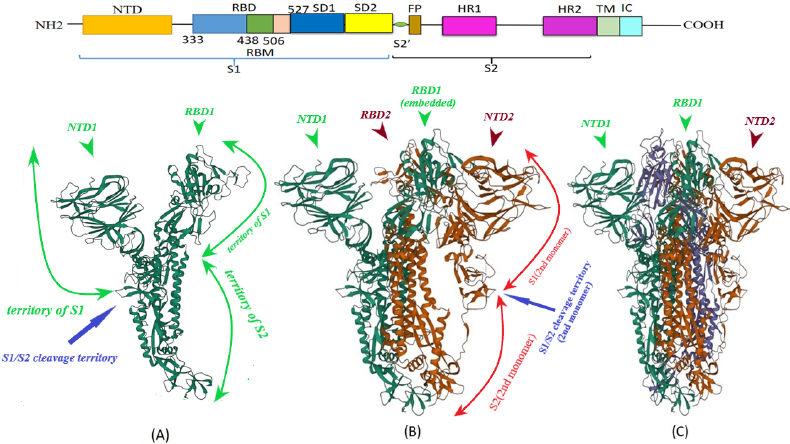
Figure 1. SARS-CoV-2 spike protein homotrimeric structure ( C ) (PDB ID: 7QUS [28]). Monomers (visualized as green, red and blue structures) are added one by one, from ( A ) to ( C ), to show how each monomer is folded and the dimeric as well as the trimeric structures are inter ‐ twisted. It makes boundary identification of S1/S2 interface in a three ‐ dimensional view difficult to show, yet has been depicted here by green curve arrows for simplification. The territory of S1/S2 cleavage site is also pointed (blue arrow). It is noticeable how in “closed, D” conformation (see the text, Section 3), RBD in the first monomer ( A ) is embedded in other S protein residues when the second ( B ) and third ( C ) monomers are added. This complex feature of S protein molecule leads RBDs to pack together as inaccessible domains in the “D” conformation (see the text below). NTD: N ‐ terminal domain; RBD: receptor binding domain. 3. Binding of ACE2 with RBD Increases the Chance of Further Complexification of ACE2 and SARS ‐ CoV ‐ 2 Binding of RBD with ACE2 is the first step of virus cell entry. Glycosylation of ACE2 and RBD residues may block this process [29]. However, RBDs in a trimeric S protein are not always accessible for this complexification and may be packed together [30]. Consti ‐ tutively, the RBD position within the S1 structure shifts dynamically through an intrinsic hinge ‐ like movement between “open or up (U)” and “closed or down (D)” states [23] (Fig ‐ ure 2). RBD in U status moves outward the apex of S1 domain to be ACE2 ‐ accessible while in D position it hides within the protein apex to be ACE2 ‐ inaccessible [31] (Figure 1 and Figure 2). As to the trimeric nature of S protein and considering U or D states of RBD, the apex of the trimeric S1 might harbor symmetric three open (UUU) or three closed (DDD) RBDs as well as intermediate asymmetric conformations of one open/two closed (UDD) or two open/one closed (UUD) ACE2 ‐ binding domains. The predominant RBD confor ‐ mation (UUU, DDD or other intermediates) differs in the variants of the SARS ‐ CoV ‐ 2 [32]. Recent studies attributed the escalated transmissibility and virulence of the new mutant variants to the abundancy and stability of RBD in the U state [32,33]. Moreover, according to cryo ‐ electron microscopy findings, docking of the single open RBD to ACE2 induces a rotation of the same domain which provokes its center of mass within the UDD complex to move approximately 5.5 Å away from the axis of the whole trimeric S protein molecule. This rotation is accompanied by moving of the three NTDs in the trimer of about 1.5–3.0 Å [34] which results in a reduction in the contact area among S1 subunits and the neigh ‐ boring S2 core. This causes successive gaining of U state in the neighboring two D ‐ posi ‐ tioned RBDs within the trimeric S protein [34] (Figure 1). To make it more clear, it should be noticed that in ACE2 ‐ unbound form of closed RBD, there are π ˗ π interactions among some residues of S1 in one protomer and Tyr(Y)837 of S2 in the neighboring protomer in addition to a salt bridge between Asp(D)614 of S1 and Lys(K)854 of the S2 which are dis ‐ ordered after ACE2 binding [34]. In D614G (Asp614 to Glycine) mutation, the hydrogen